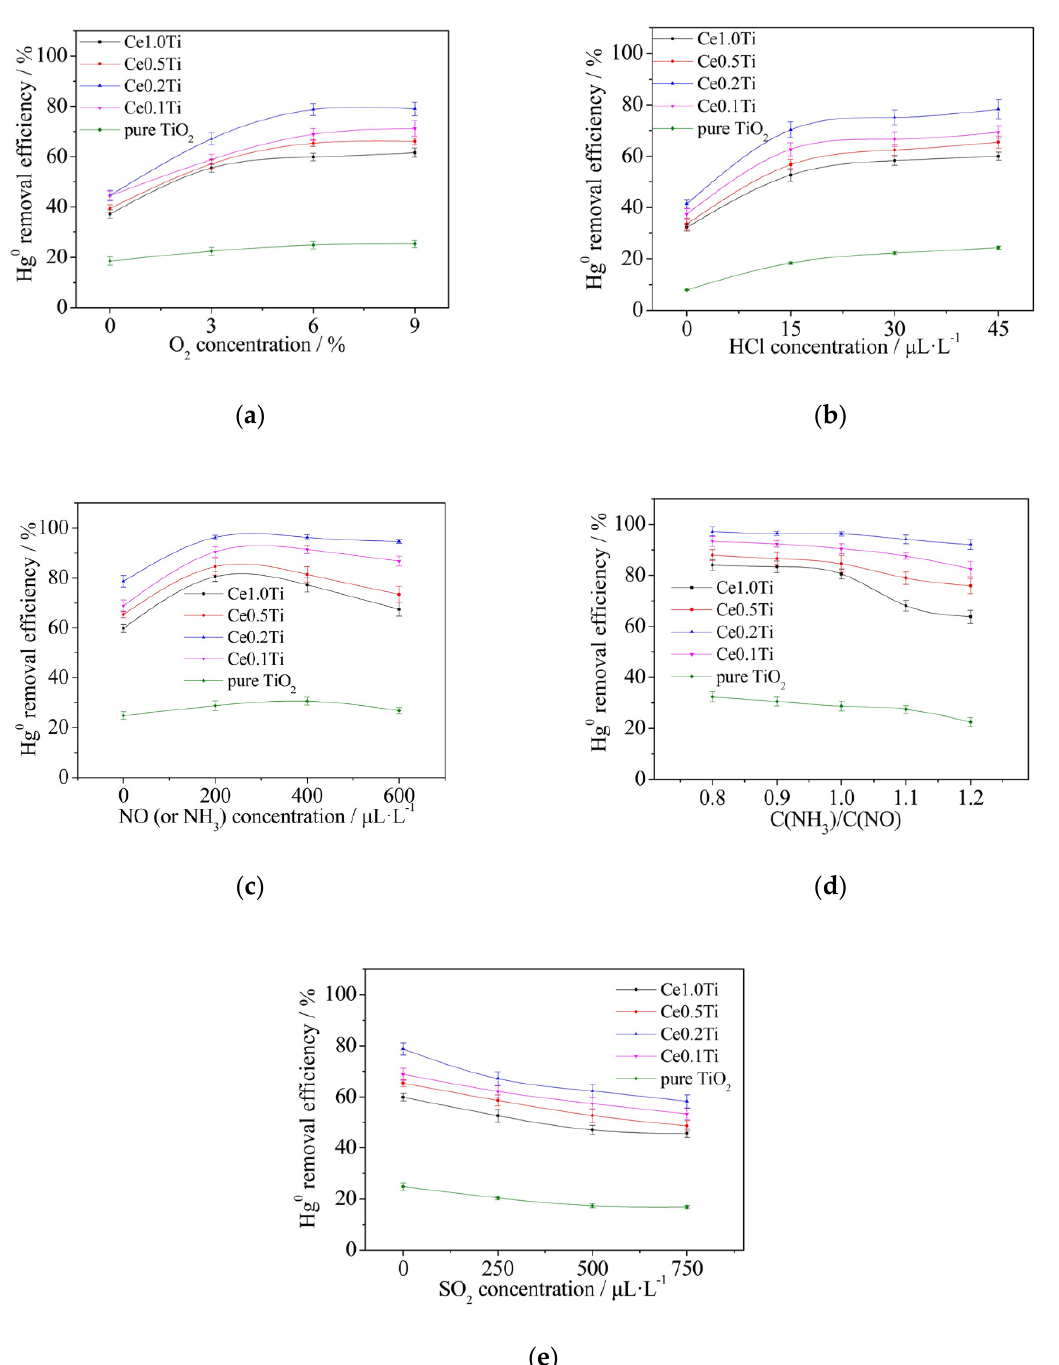
Figure 4. The e ff ects of flue gas components on catalytic performance; ( a ) the e ff ct of O 2 ; ( b ) the e ff ect Figure 4. The effects of flue gas components on catalytic performance; ( a ) the effct of O 2 ; ( b ) the effect of HCl; ( c ) the e ff ect of NO and NH 3 ; ( d ) the e ff ect of the ratio of NH 3 / NO; ( e ) the e ff ect of SO 2 of HCl; ( c ) the effect of NO and NH 3 ; ( d ) the effect of the ratio of NH 3 /NO; ( e ) the effect of SO 2 .